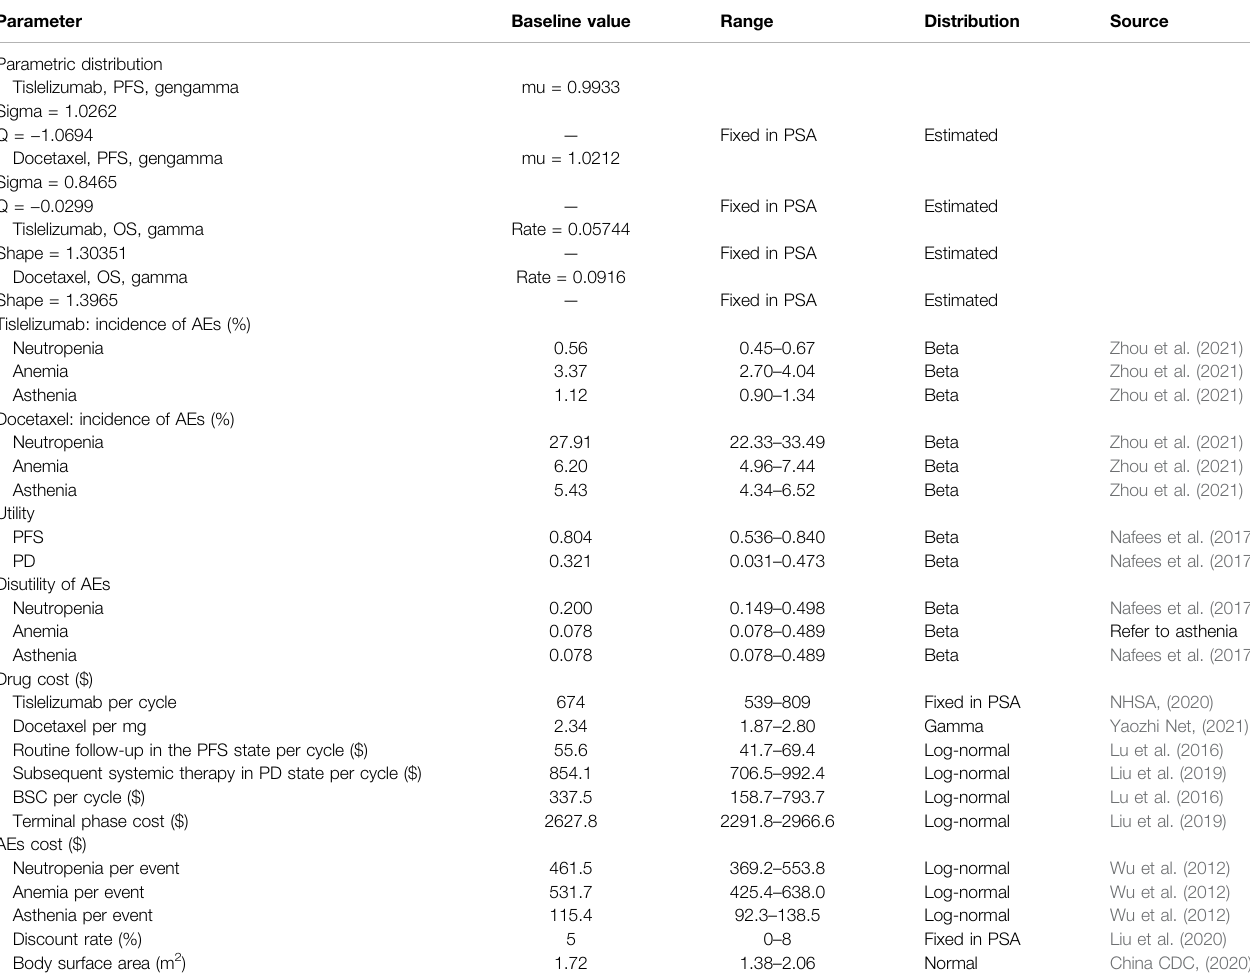
TABLE 1 | Summary of key parameters input to the model.